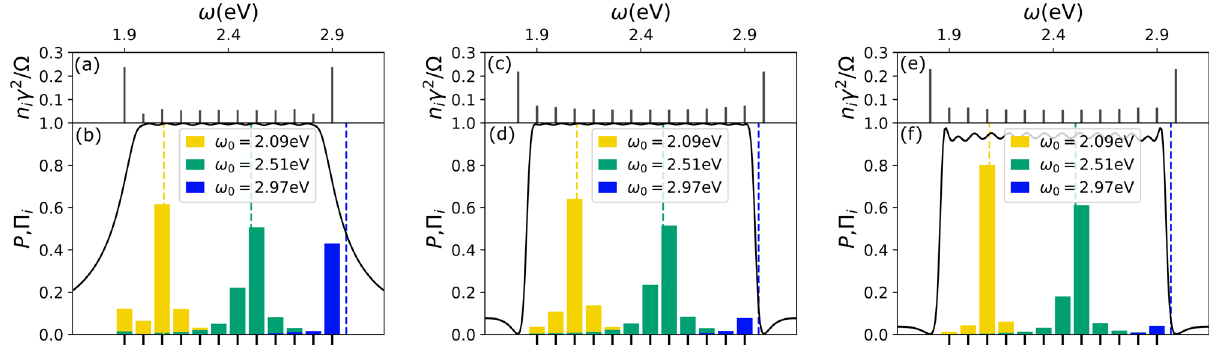
Fig. 3 Performance of photodetector. a , b Implementation for N = 12 frequency bins when all the absorbers are monitored. Here the incoherent transition rate Γ 2 = 0.085 eV . c , d . N = 12 system where end subsystems that do not decay to monitored dark states are added. Here the incoherent transition rate Γ 2 = 0.082 eV . e , f A version of the design of c , d where the incoherent decay rate Γ 2 is reduced by half, resulting in higher frequency resolution but reduced overall ef fi ciency. For each con fi guration, photons of three frequencies ω 0 are considered, denoted by different colors and marked by dashed lines. In b , d , f the colored bars indicate the probability of a photon of that frequency ω 0 being detected at each bin, the characteristic frequencies of which are marked by the x-axis